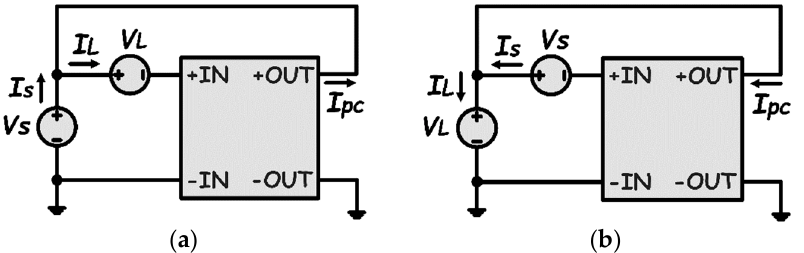
Figure 11. PPC topologies that do not require isolated DC–DC converters: ( a ) step-up; ( b ) step-down.